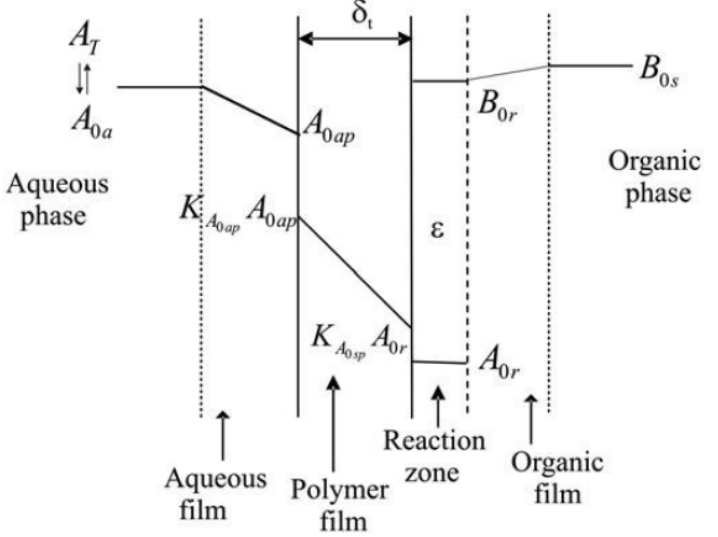
Figure 44. Schematic showing the concentration profiles across the polymer film during IP reaction. From reference [71].